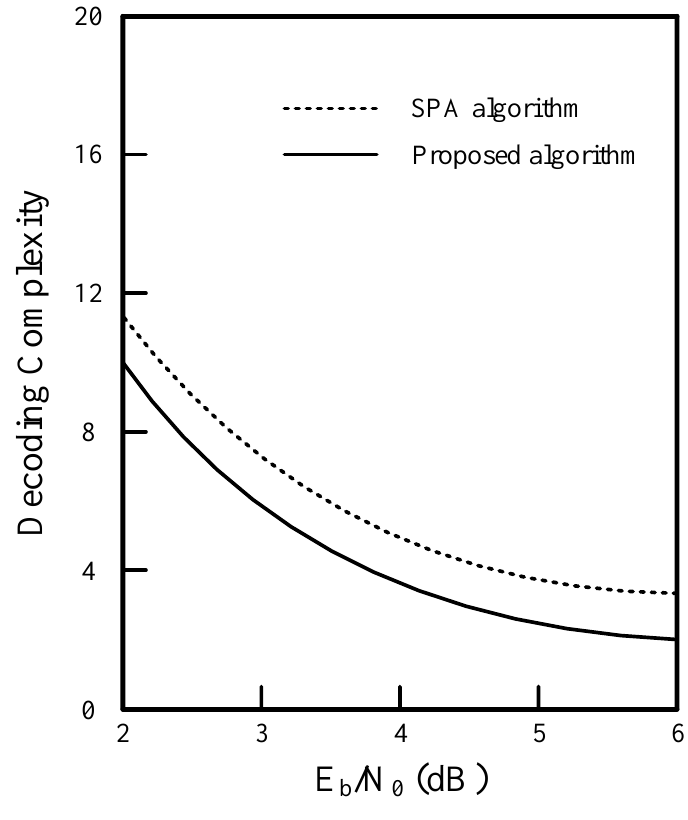
Figure 4. Complexity of Golay (23,